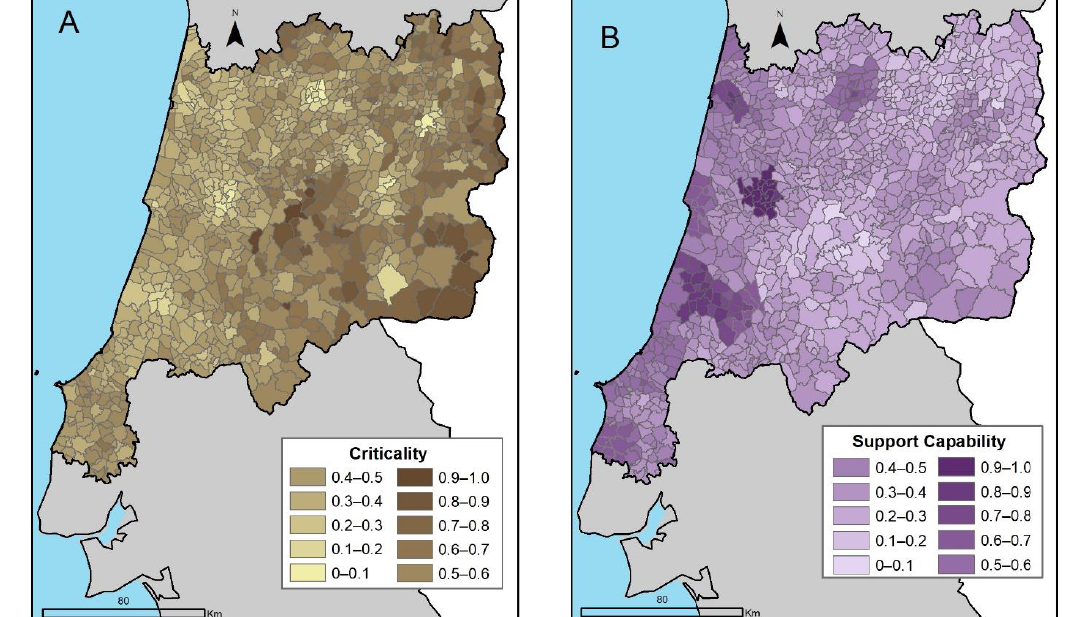
Figure 7. The two dimensions of social vulnerability: ( A ) criticality; ( B ) support capability. Values were re-scaled to 0 – 1 and are shown classified in equal intervals.